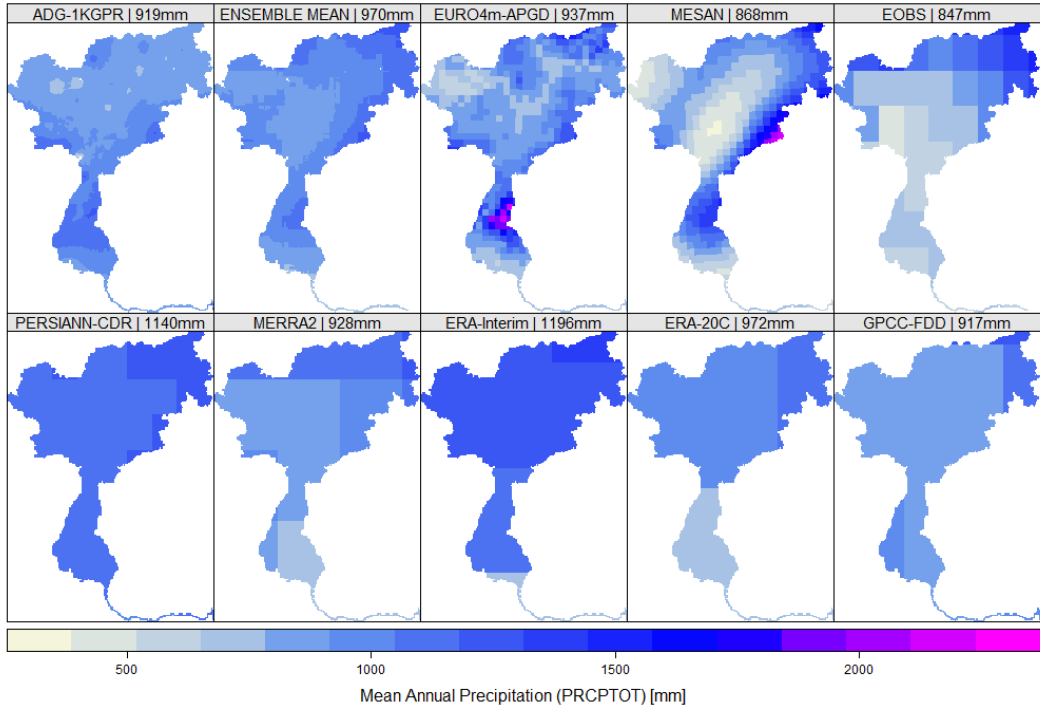
Figure 5. Mean annual precipitation over the catchment for the applied data sets including the ensemble mean; numbers in the panels correspond to the mean catchment precipitation.